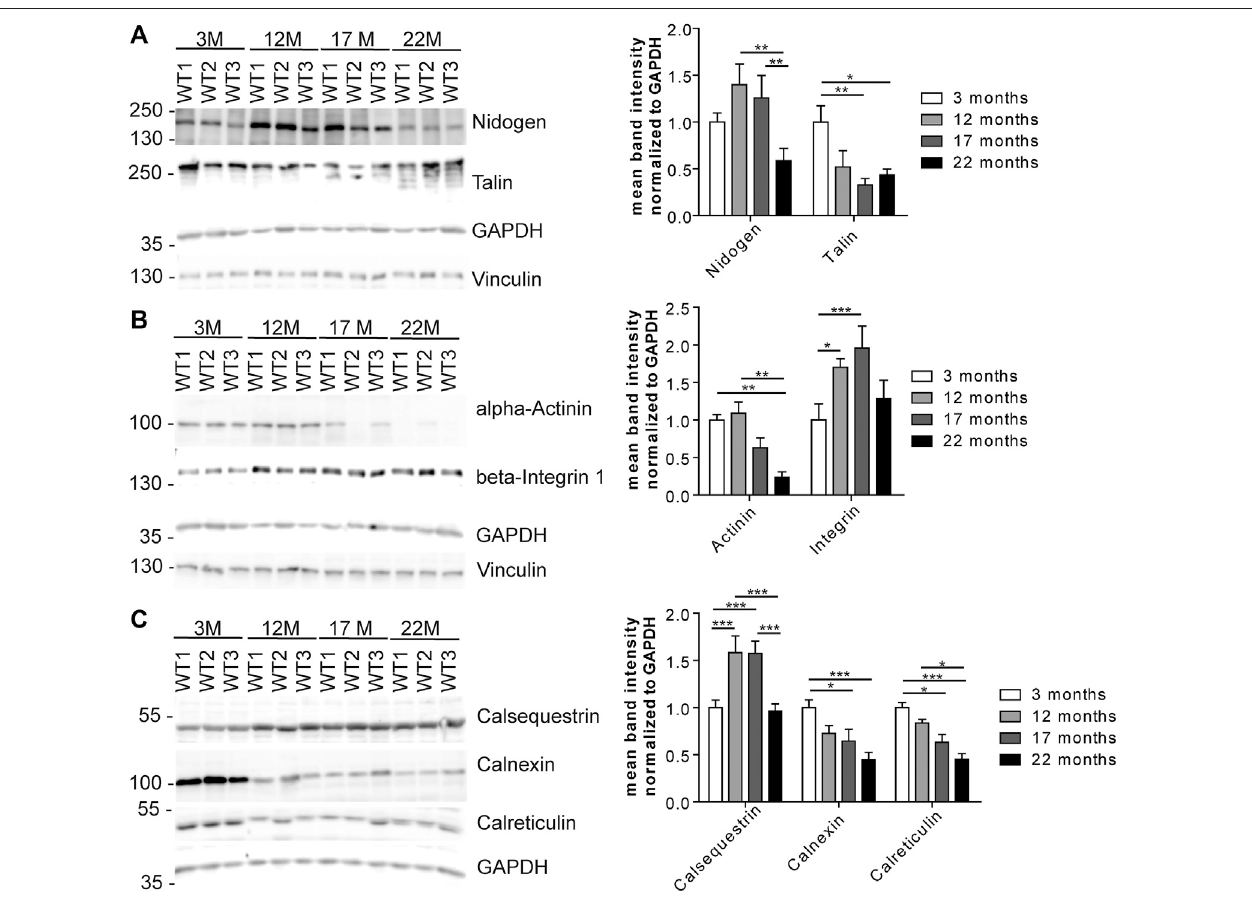
FIGURE 6 | Expression of candidate proteins involved in stabilization, organization, signaling and stress responses identi fi ed in aging C57BL/6J male hearts. (A) Western Blot analysis of candidate glycoproteins identi fi ed by mass spectrometry after Con A pull-down. GAPDH and vinculin served as loading control ( n (cid:2) 6 mice per age; 2-way ANOVA with Bonferroni posthoc test). (B) Western blot analysis of the candidate protein alpha-actinin and the talin-interacting protein beta-integrin 1. GAPDH and vinculin served as loading control ( n (cid:2) 6 mice per age; 2-way ANOVA with Bonferroni posthoc test). (C) Western Blot analysis of calcium-binding ER proteins selected after mass spectrometry of lectin pull-down. GAPDH served as loading control ( n (cid:2) 6 mice per age; 2-way ANOVA with Bonferroni posthoc test). Quantitative data are presented as mean ± SEM. Individual data points are shown in Supplementary Figure S2 .